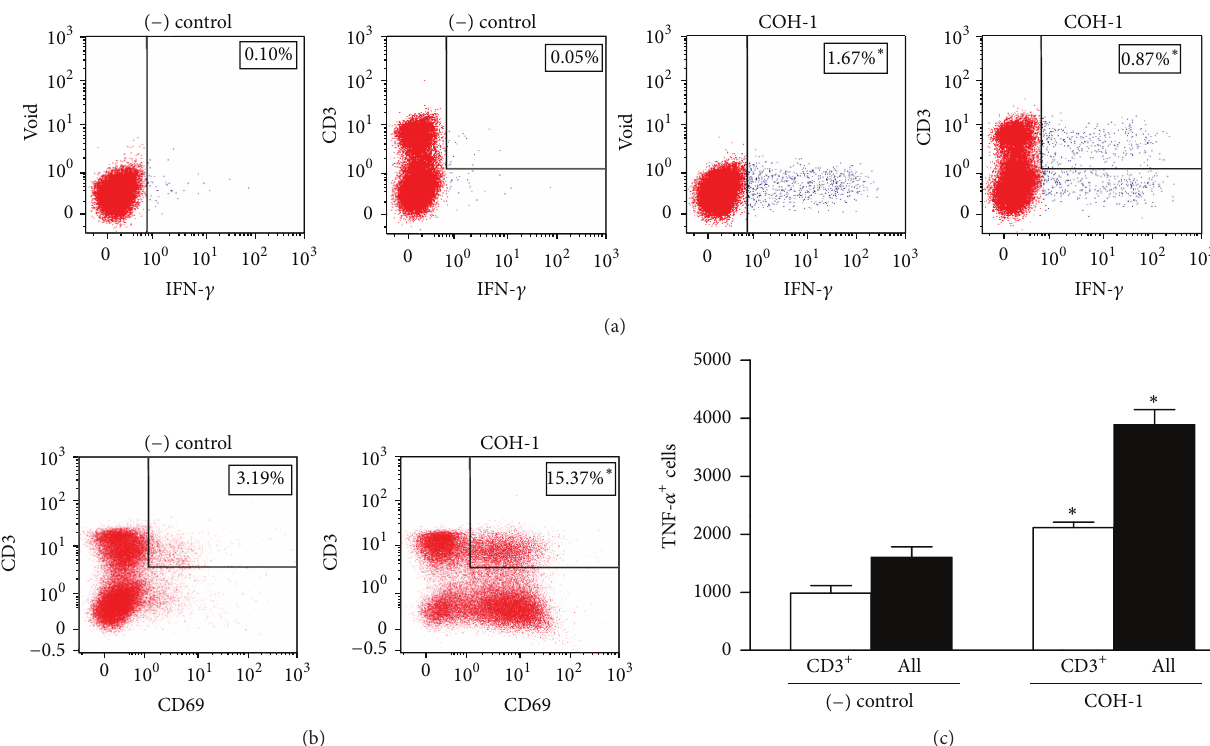
Figure 3: Ex vivo analyses of cellular sources of IFN- 𝛾 during GBS infection. C57BL/6 mice were injected intraperitoneally with a dose of 10 7 CFU of wild-type GBS serotype III strain COH-1 ( 𝑛 = 3 per group × 3 individual experimental infections). Spleens were harvested 6h after infection and total splenocytes plated at 5 × 10 6 cells/well. After 4 h of incubation, the bacteriostatic agent chloramphenicol (12 𝜇 g/mL) was added to the culture to prevent cell toxicity. Nonstimulated cells from mock-infected animals served as negative ( − ) control for basal expression. Total splenocytes were incubated for 48 h with Brefeldin A (3 𝜇 g/mL) added during the last 5 h of incubation. Cells were harvested and intracellularly stained for IFN- 𝛾 (a) or surface-stained for CD69 (b) in combination with several surface markers for multiparametric FACS analysis. Representative data from 3 different experimental infections based on CD3 + population or total splenic population (Void). (c) Number of TNF- 𝛼 + cells within the CD3 + population or total splenic population (All). Data are expressed as means ± SEM from 3 different experimental infections; ∗ 𝑃 < 0.05 indicates statistically significant difference compared to ( − ) control cells. Fifty thousand gated events were acquired per sample and data analysis was performed using FACSDiva TM